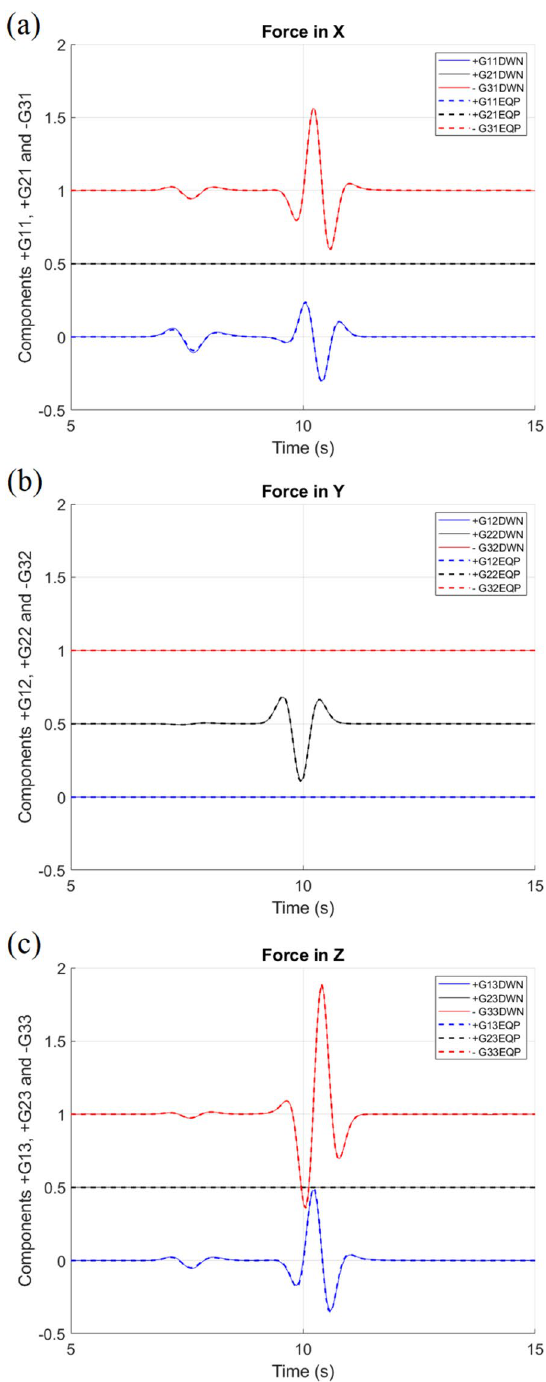
Fig. 6 Synthetic seismograms are given in the panels a, b and c for the three forces in directions x , y and z , respectively, at the origin and 5 km both on the surface of a half‑space with the receiver at x 1 = Poisson ratio of 1/3. The P and S wave velocities are 2 and 1 km/s, 10 3 kg/m 3 . The chosen source was respectively. Mass density is 2 × a Ricker pulse with “characteristic” period of 1 s and centered at 5 s. The maximum load value in absolute value is R 0 in GN ( 10 9 Newtons ) . Results from DWN are given with continuous lines as indicated in the legends. The synthetics using EQP are superimposed with dotted thick lines. The ordinates’ unit is meters after the common factor 1 2 π 10 4 R − 0 is applied